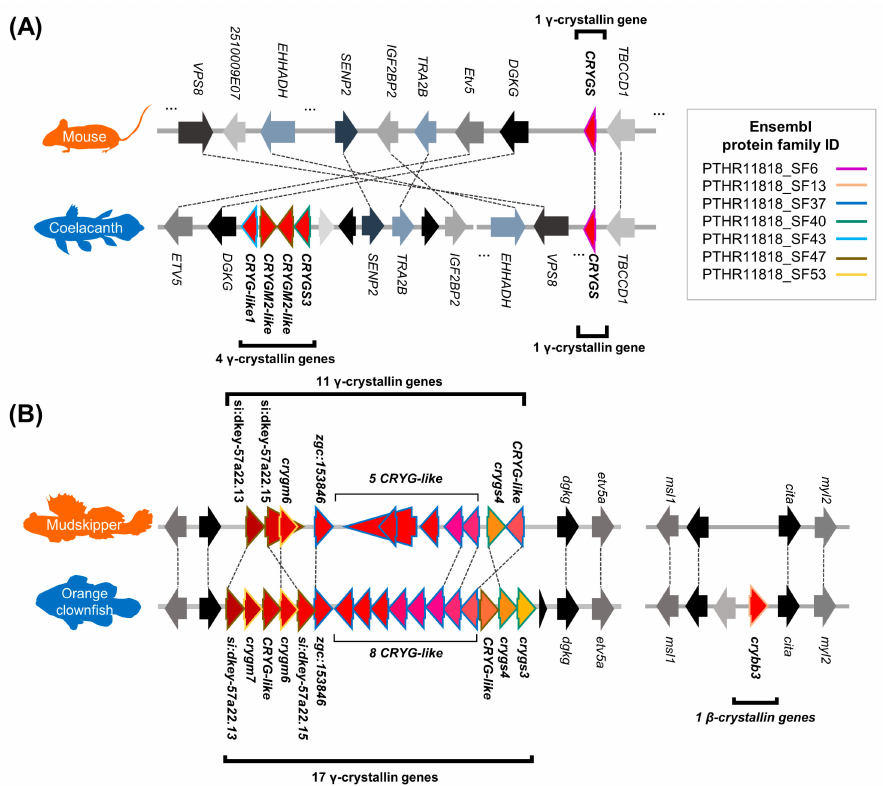
Figure 6. Synteny near the βγ -crystallin coding genes that were contracted in terrestrial vertebrates. Dashed line indicates orthologous relationship. ( A ) Four less γ -crystallin coding genes in mouse genome compared to that of coelacanth with the syntenic support. ( B ) Six less γ -crystallin coding genes (left) and one less β -crystallin coding gene (right) in the mudskipper genome compared to the that of orange clownfish with the syntenic support. Genomic coordinates are available in the Supplementary Table